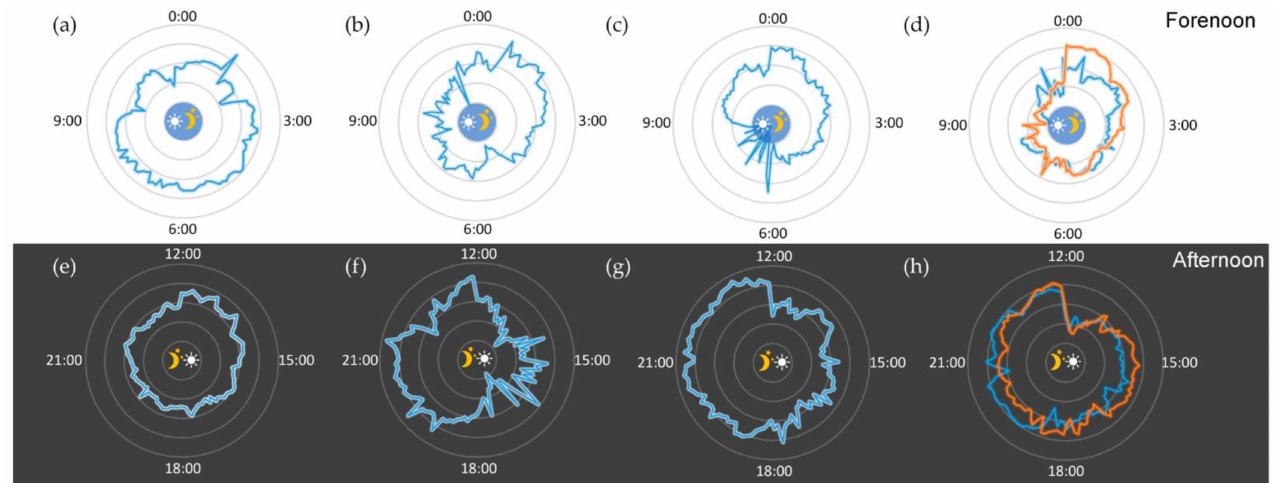
Figure 9. Body temperature recorded by graphene-enhanced PDMS wearable temperature patch: ( a ) forenoon data recorded in regular daily life (1/2 day); ( b ) forenoon data recorded in regular daily life (2/2 day, without diet); ( c ) forenoon data recorded after high-intensity training; ( d ) forenoon data recorded after over-night working (blue line: day 1, orange line: day 2); ( e ) afternoon data recorded in regular daily life (1/2 day); ( f ) afternoon data recorded in regular daily life (2/2 day, without diet); ( g ) afternoon data recorded after high-intensity training; ( h ) afternoon data recorded after over-night working (blue line: day 1, orange line: day